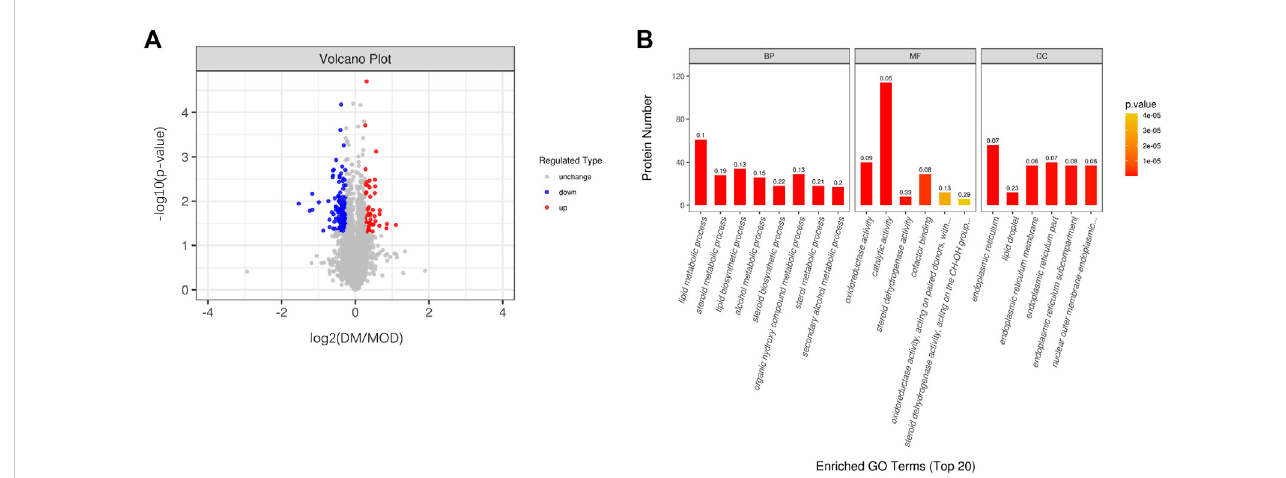
FIGURE 1 (A) Volcano plot showing signi fi cantly up- (red) or downregulated (bule) proteins between the DM group and the model group. The gray points are proteins whose expression levels did not change signi fi cantly. (B) GO terms of the DSEPs in the DM treatment group compared with the model